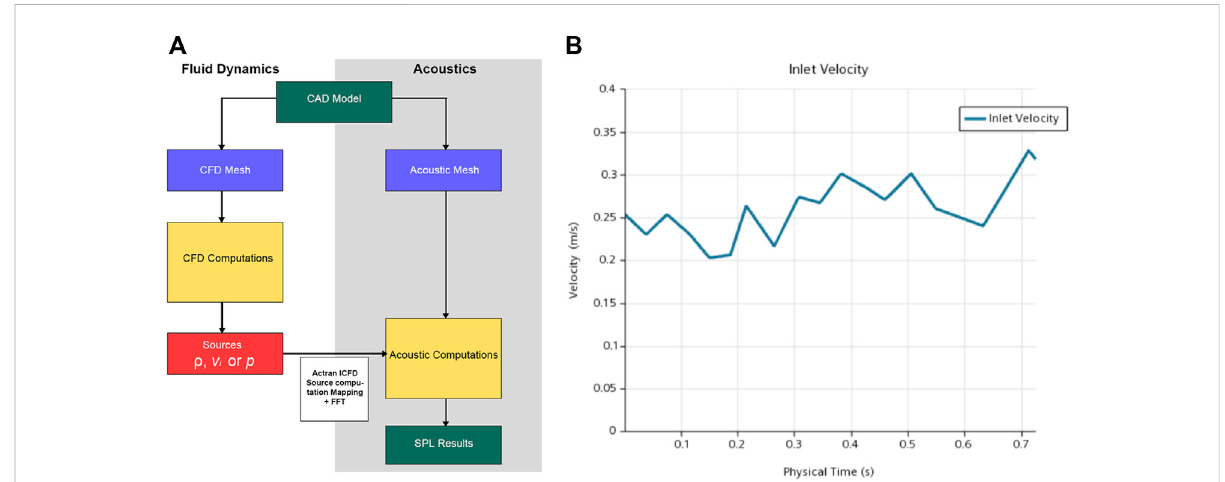
FIGURE 5 (A) Work fl ow of computational fl uid dynamics (CFD) simulation. First, the pressure, density, and velocity fi elds output by the CFD solver were read; second, contributions according to the fi nite element method formulation were implemented; third, the contributions were projected on the acoustic mesh; fourth, the corresponding data were stored and displayed; and fi fth, the quantities from the time to the frequency domain were transformed via Fourier transform. (B) The velocity inlet set for computational simulation.